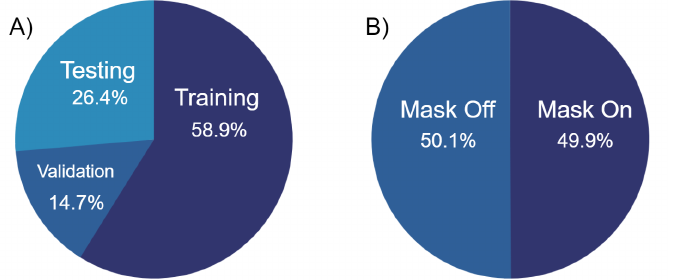
Figure 3. Dataset description: ( A ) data-sample and ( B ) total class distribution.